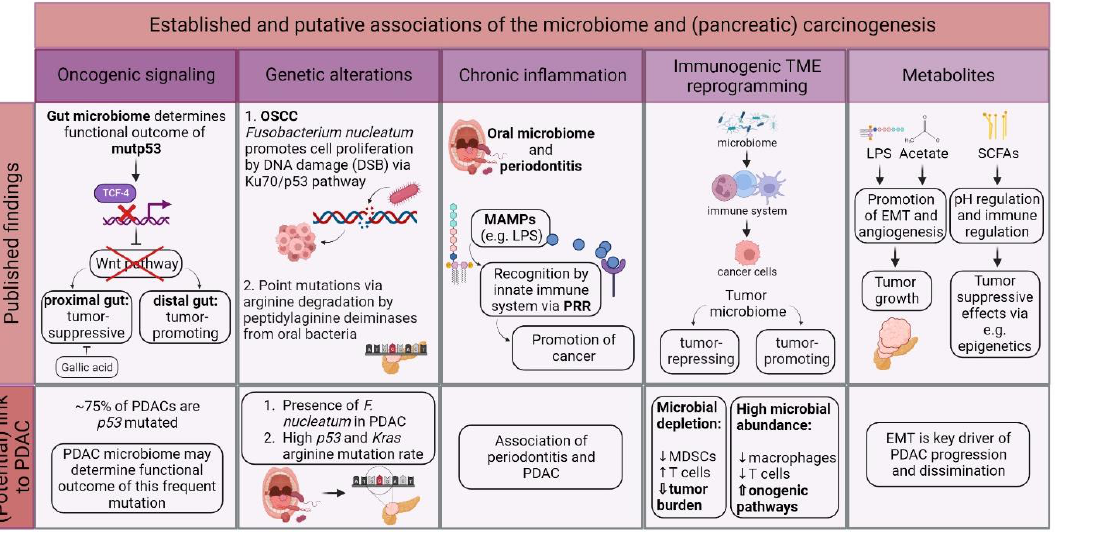
Figure 2. Potential involvement of the microbiome in (pancreatic) oncogenesis. There is growing evidence on how different microbiomes contribute to carcinogenesis, e.g., via promoting oncogenic signaling, direct and indirect genetic alterations, chronic inflammation, and interaction with the immune system and secretion of microbe-derived metabolites. However, most of these theories have yet to be validated in PDAC patients. Tumor microenvironment (TME); mutant p53 (mutp53); pancre- atic ductal adenocarcinoma (PDAC); oral squamous cell carcinoma (OSCC); desoxyribonucleic acid (DNA); double-strand break (DSB); microbe-associated molecular pattern (MAMP); lipopolysaccha- ride (LPS); pattern recognition receptor (PRR); myeloid-derived suppressor cell (MDSC); short-chain fatty acid (SCFA); epithelial-to-mesenchymal transition (EMT); and pondus hydrogenii (pH).